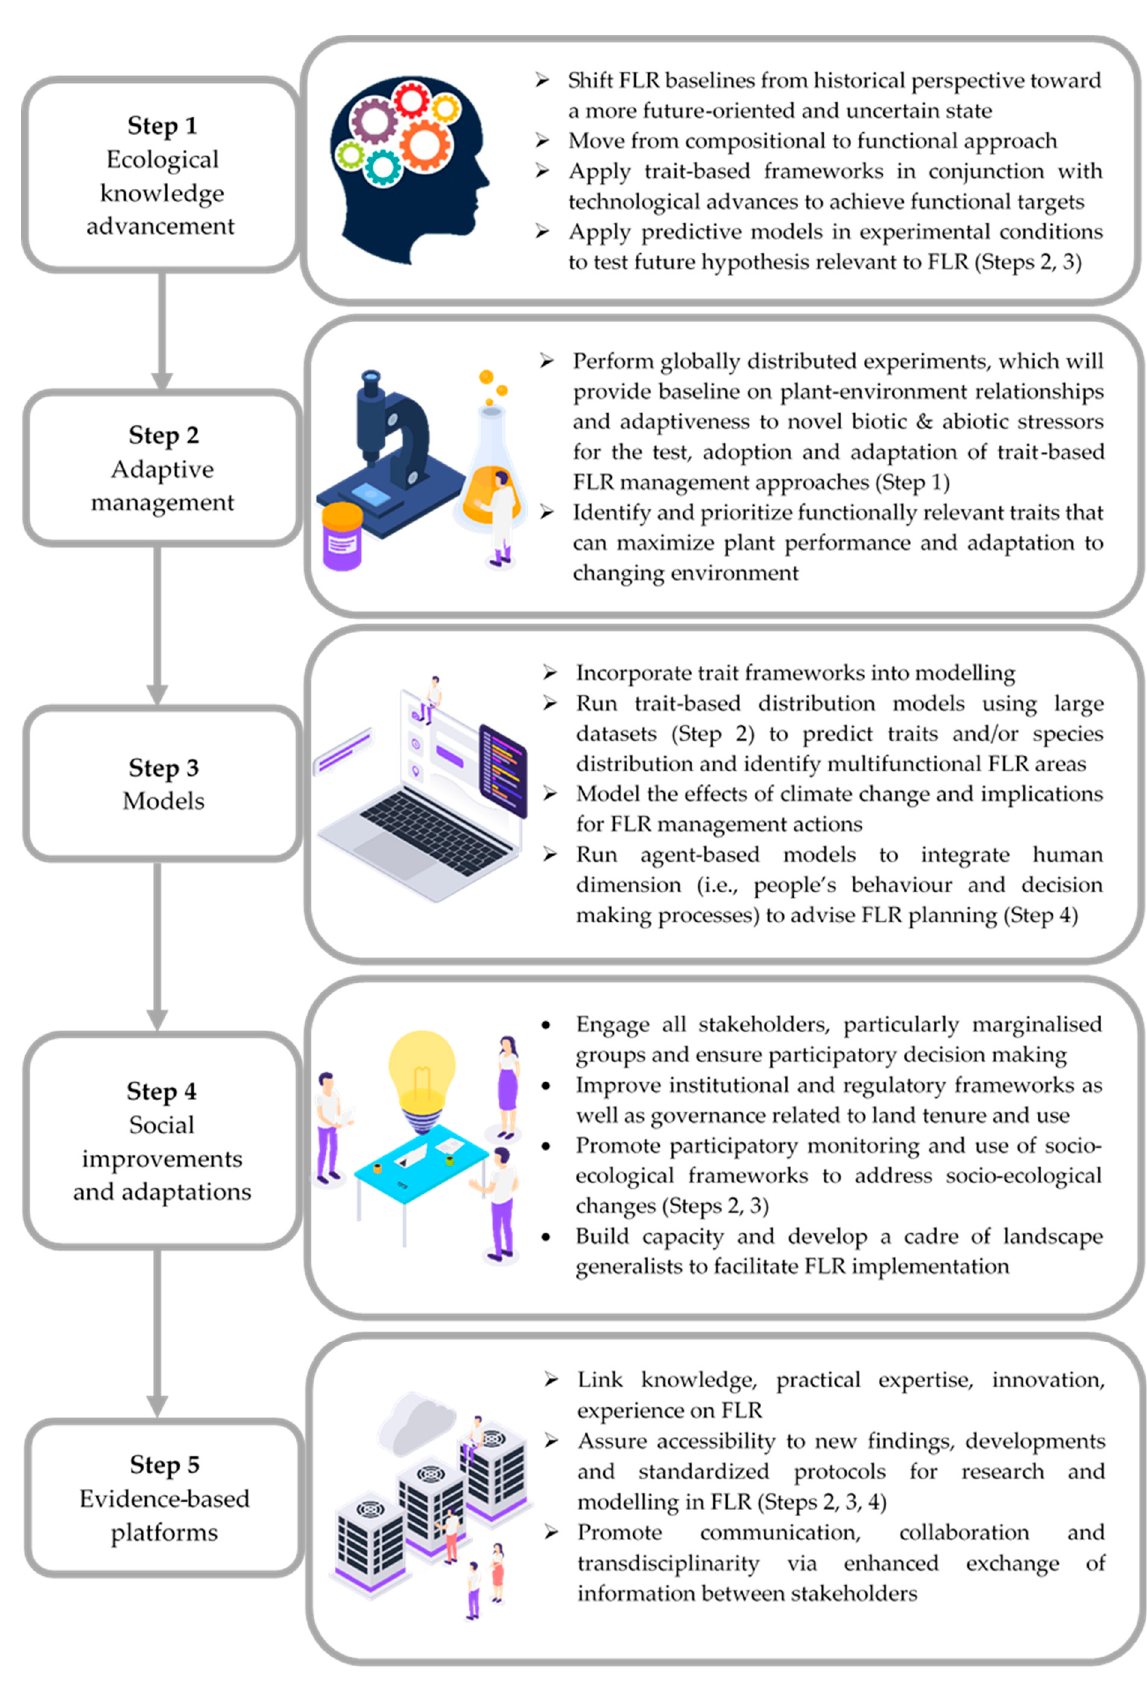
Figure 2. Proposed roadmap including concrete suggestions for the successful implementation of FLR under global environmental change. Interconnectedness within the roadmap is indicated by the working steps in parentheses.